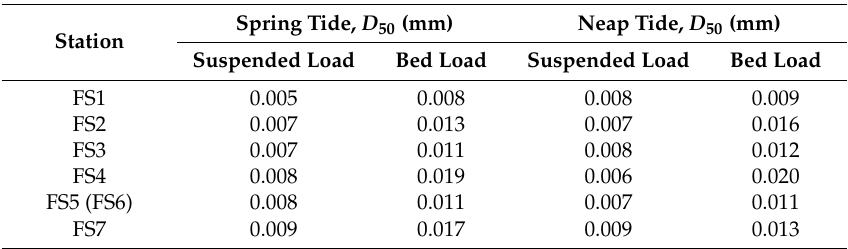
Table 2. Median grain sizes ( D 50 ) of suspended and bed load during the wet season (second half of June 2015).